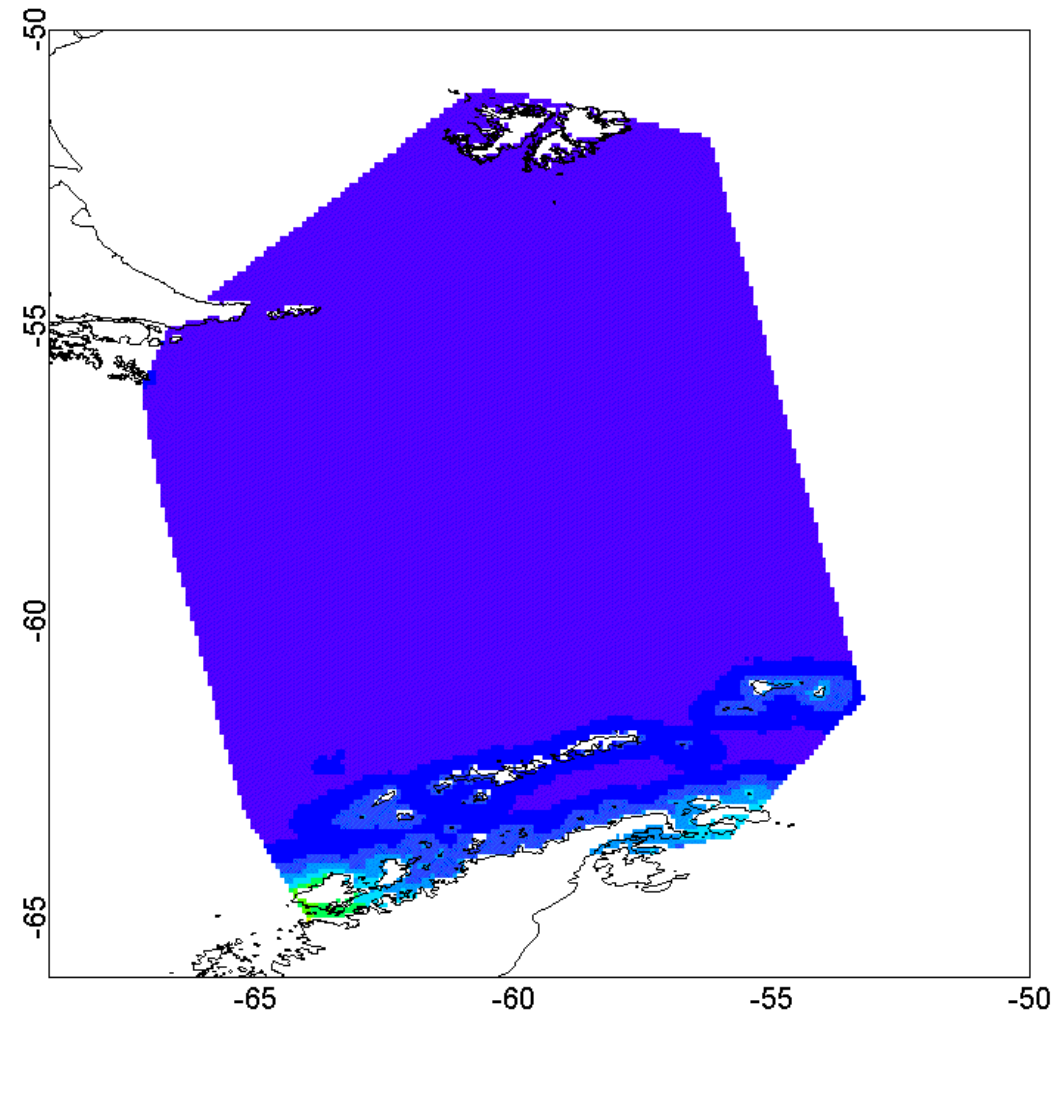
Fig. 7. An animation showing variation in predicted density of minke whales at each iteration. All grid squares were predicted to have <0.22 minke whale schools/nm 2 . The longest axis of the prediction grid (from the southern tip of South America to the northern tip of the Antarctic Peninsula) is approximately 500 nm long. Areas close to shore, and in the icy waters off the northern tip of the Antarctic Peninsula were predicted to have high densities of minke whales in each